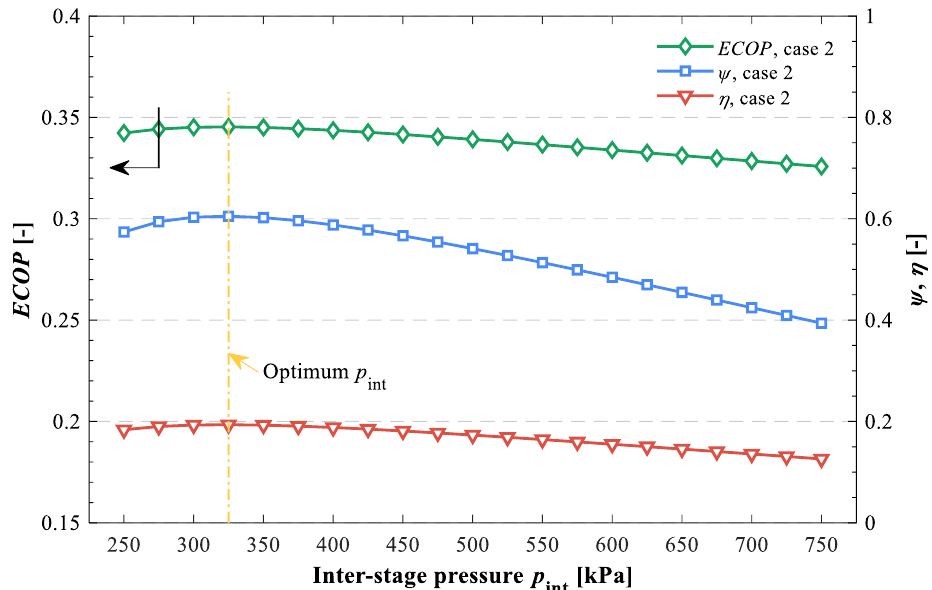
Figure 10. Effect of inter-stage pressure on performance indicators for two-stage cycle with thermal and mechanical compression processes in case 2.